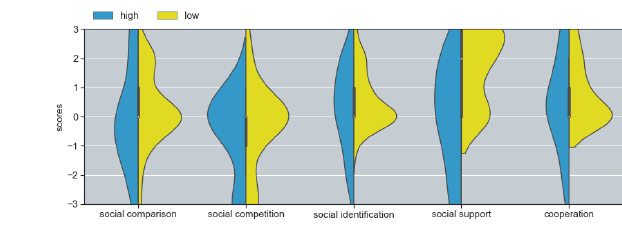
Figure 6. Motivational design techniques regarding social